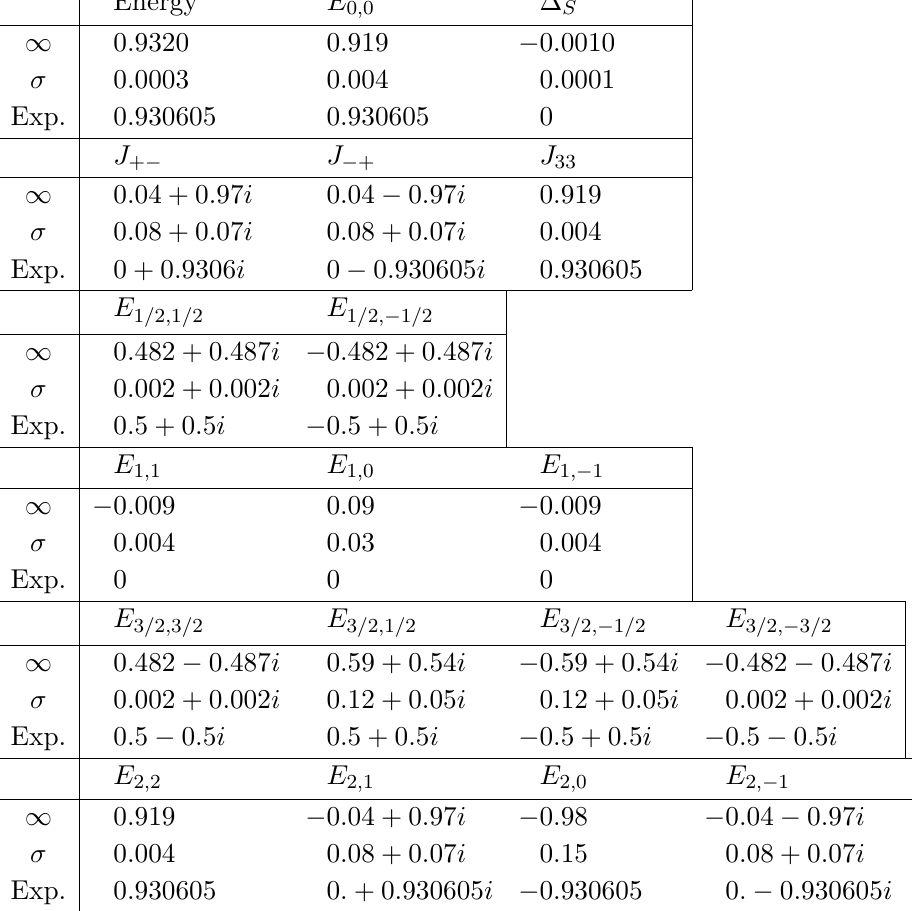
Table 6 . Extrapolations of gauge invariants of a solution describing J = 1 in the k = 4 model with J = 1 boundary θ = π 4